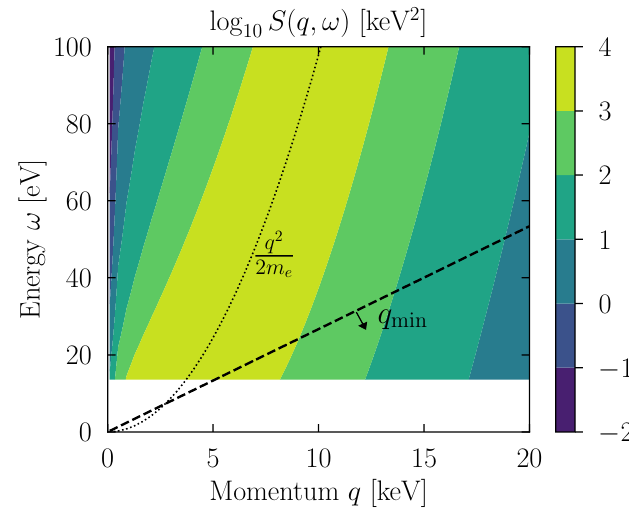
Figure 4: The dynamic structure factor for ionization of hydrogen, obtained using Eq. (55) with an arbitrary reference n the electron becomes less important and the peak of the structure factor converges to the free-particle dispersion ω = q 2 / ( 2 m line is the minimum q for DM scattering, Eq.